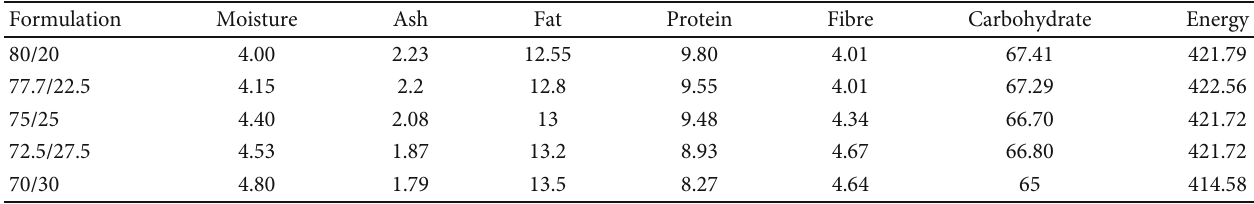
Table 3: Proximate analysis outcome on the processed cereal formulations (g/100 g) (Zeaco fl akes). Formulation